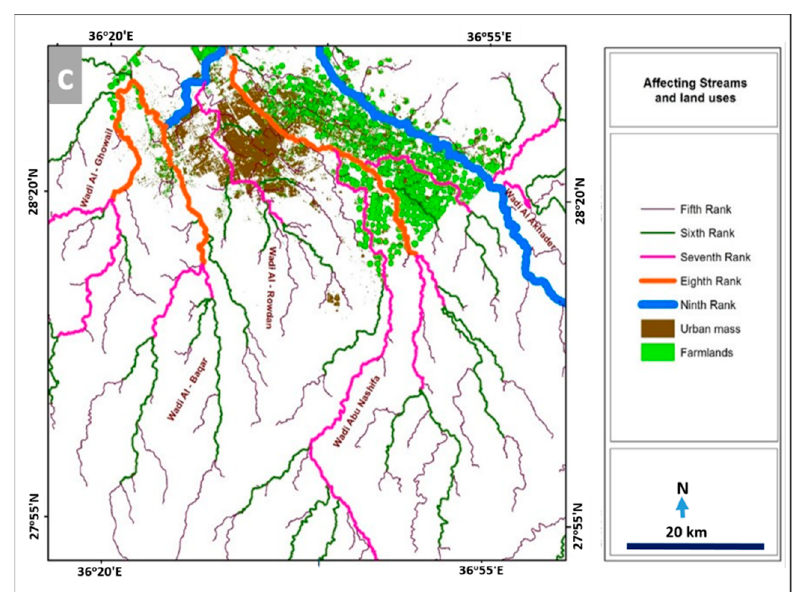
Figure 5. ( a ) The 5 m DEM of the study area, ( b ) extracted drainage networks and basins affecting Tabuk City, and ( c ) stream orders of wadis affecting the city in 2018.